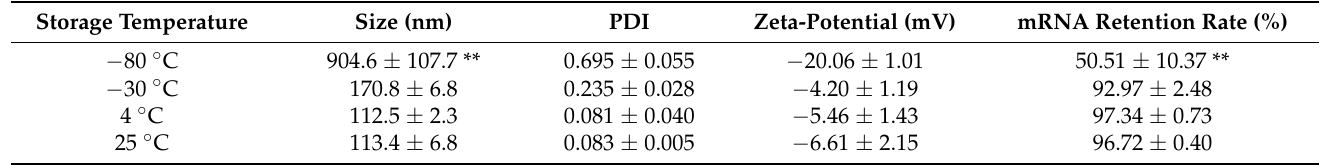
Table 2. Effects of the storage temperature on particle properties of the mRNA encapsulating LNPs.